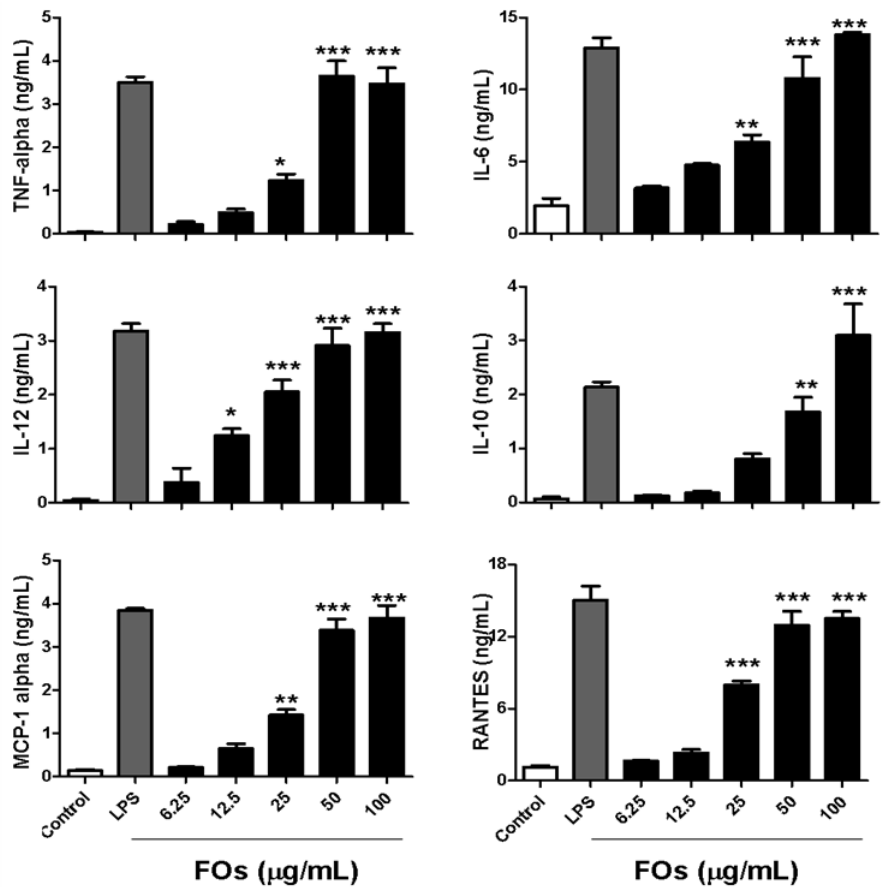
Figure 1. Cytokine and chemokine production are increased in BMDCs stimulated with FOs (12.5–100 g/mL) for 24 h (6 h for the TNF-alpha). The data are presented as the mean ± SD from triplicate well measurements from one of three independent experiments with similar results. * p < 0.05, ** p < 0.01, *** p < 0.001 was for the comparison between FOs-treated and PBS-treated control